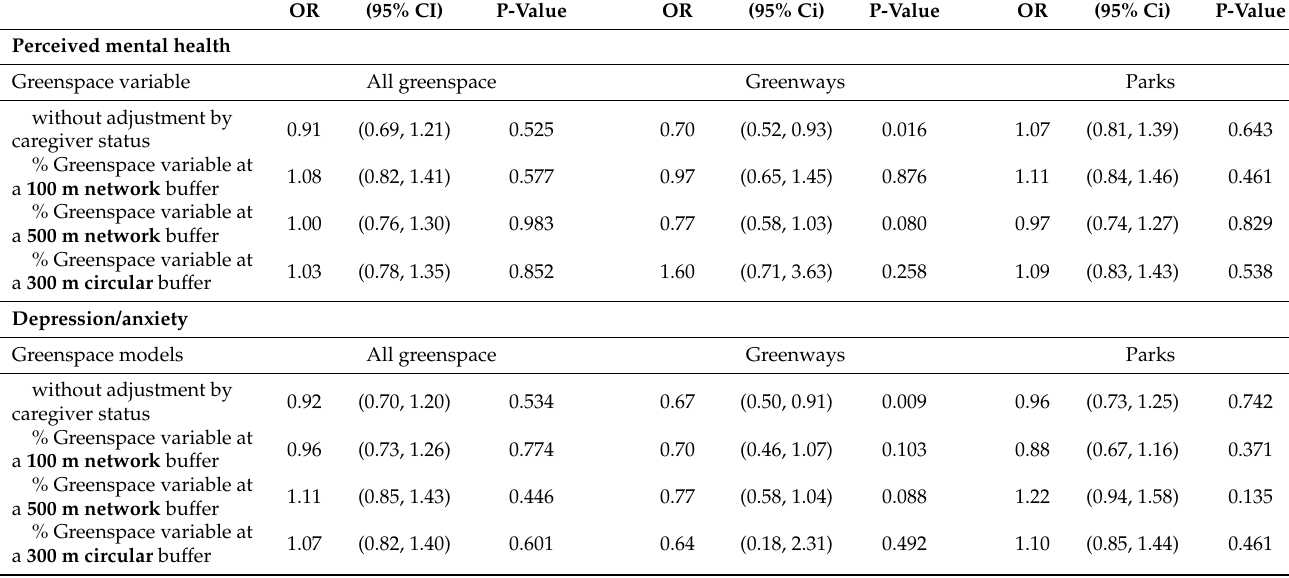
Table A2. Sensitivity analyses, testing the main analyses for perceived mental health and depression/anxiety in the greenspace models without the “caregiver status” variable.